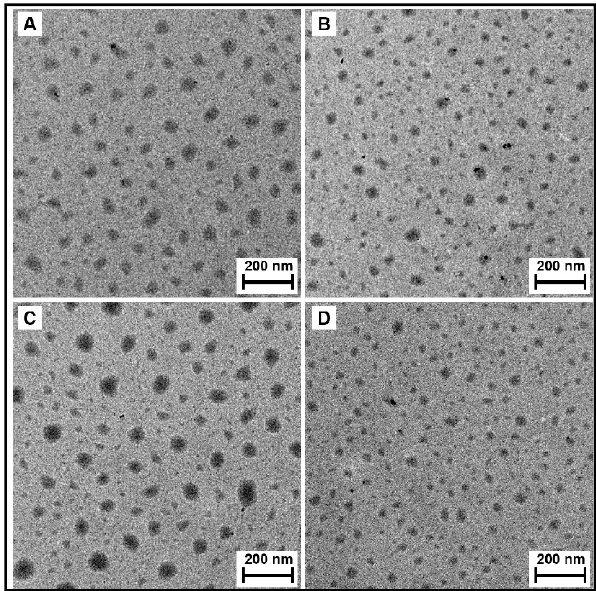
Figure 7. Transmission electron micrograph of P(HEA- co -PVS)(97/3) micelle ( A ), P(HEA- co -ABZ) micelle ( B ), P(HEA- co -PVS)(97/3)/DOX micelle ( C ), and P(HEA- co -ABZ)/DOX micelle ( D ). Bar on each micrograph represents 200 nm.